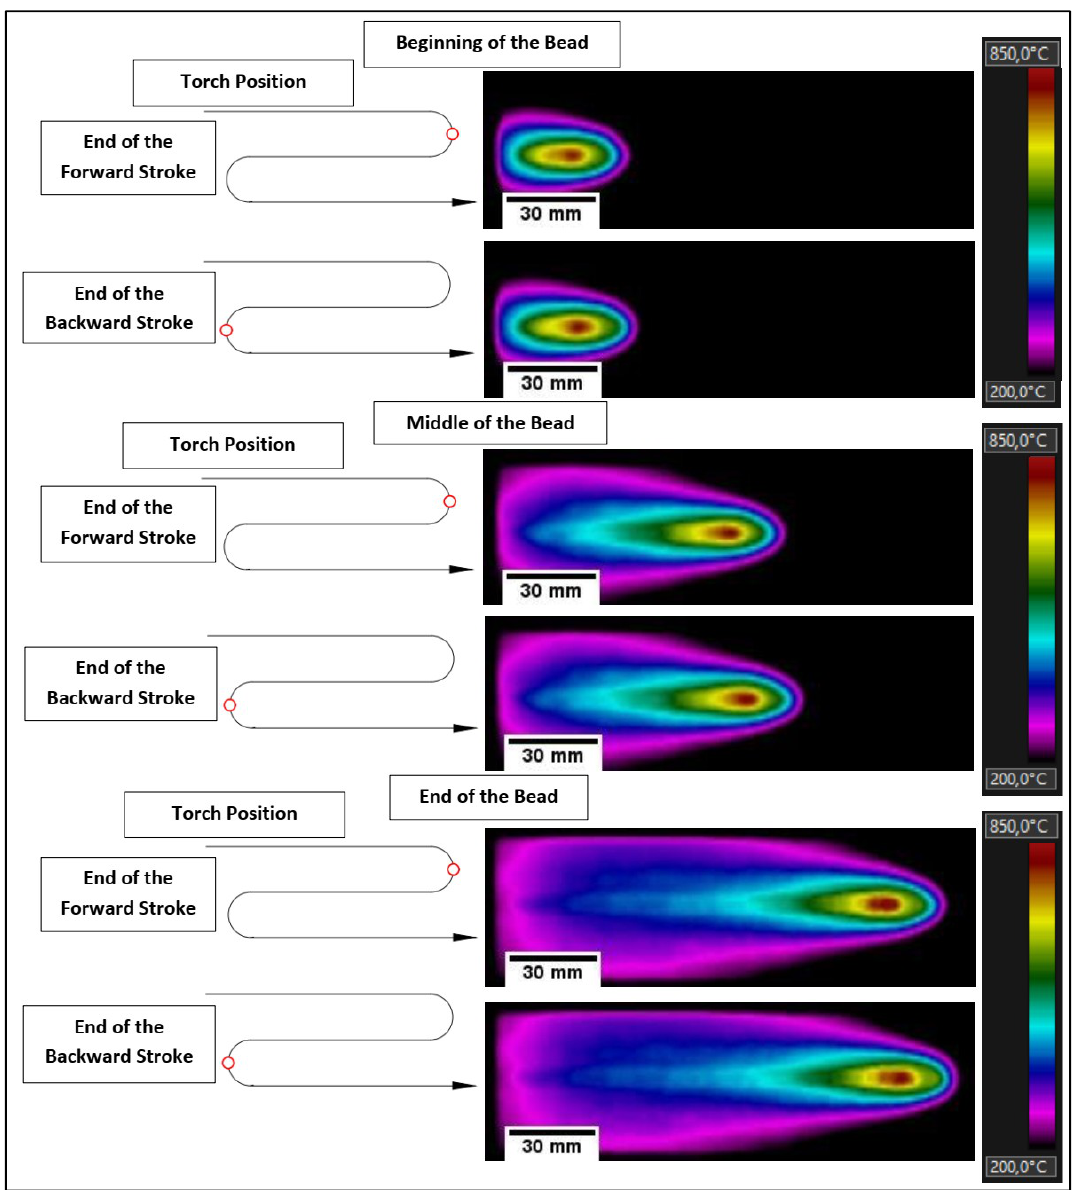
Figure 11. Thermal profile at the plate backside from the deposition T2SB (switchback with F = 10 mm and B = 5 mm) at different welding times (progressively advancing the torch position).